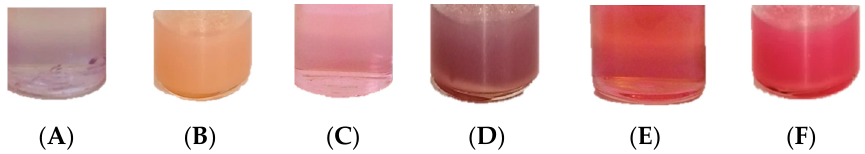
Figure 5. Lyophilized extracts in water ( A ), ( C ), ( E ) and brine ( B ), ( D ), ( F ) of red radish ( A ), ( B ), hibiscus ( C) , ( D ), and red beetroot ( E ), ( F ).